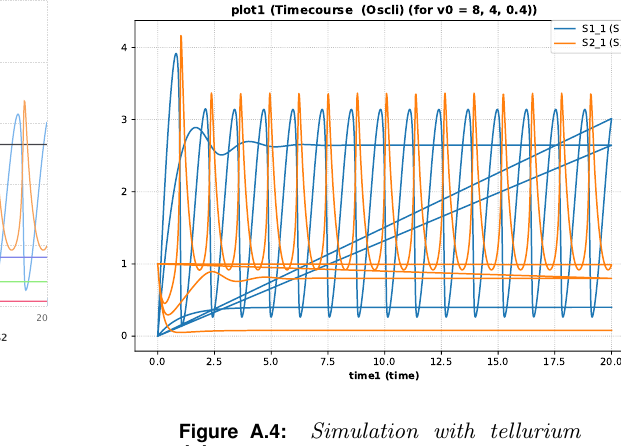
Figure A.4: Simulation with tellurium